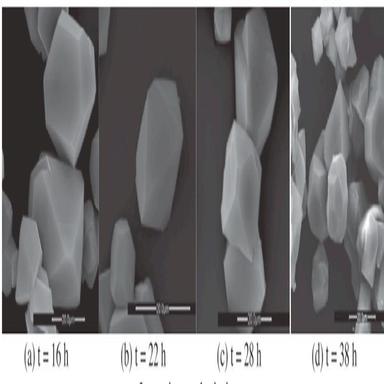
HKUST-1 SEM images for various synthesis times at 100 ◦C.